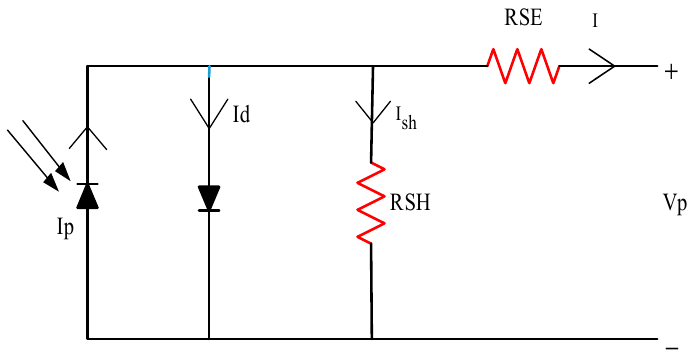
Figure 2. Equivalent circuit of PV.